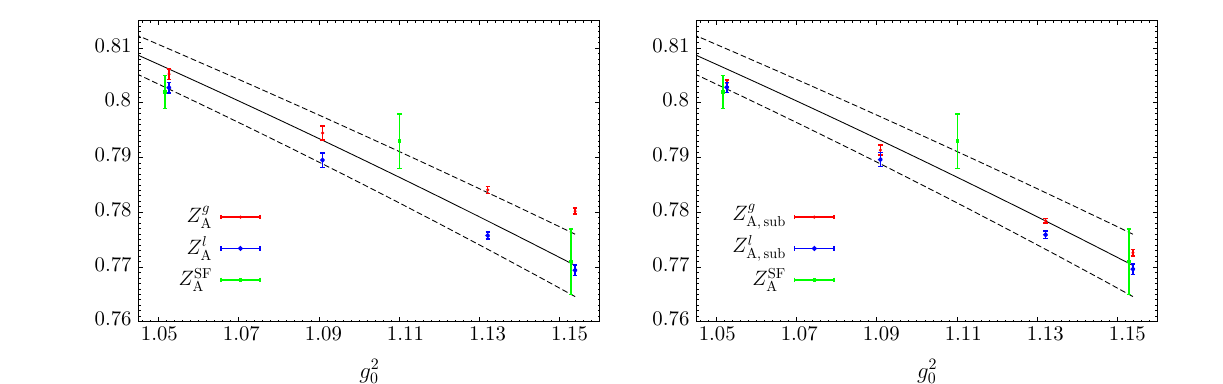
< 1, here not 0 → 0 0